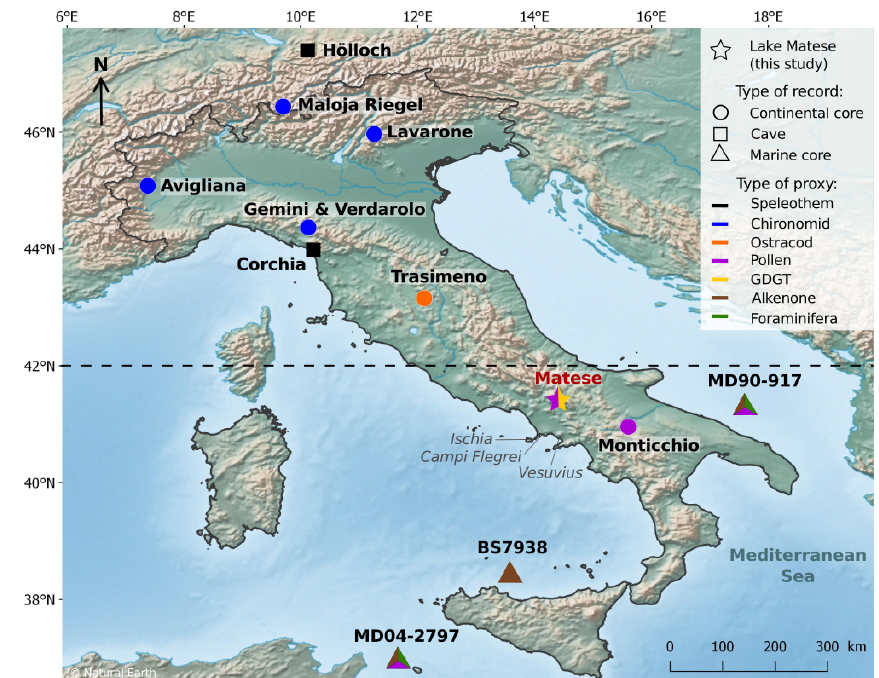
Figure 1. Location of the Lake Matese and Late Glacial paleoclimate records: Hölloch (Li et al., 2021), Maloja Riegel (Heiri et al., 2014), Lake di Lavarone (Heiri et al., 2014), Lake Piccolo di Avigliana (Larocque and Finsinger, 2008), Lake Gemini (Samartin et al., 2017), Lake Verdarolo (Samartin et al., 2017), Corchia cave (Regattieri et al., 2014), Lake Trasimeno (Marchegiano et al., 2020), Lake Grande di Monticchio (Allen et al., 2002), MD90-917 (Sicre et al., 2013; Combourieu-Nebout et al., 2013), BS7938 (Sbaffi et al., 2004), MD04-2797 (Sicre et al., 2013; Desprat et al., 2013). The dotted line indicates 42 ◦ N. The locations of active Campanian volcanoes (Vesuvius, Campi Flegrei, Ischia) are also